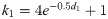
Shown is the dependence of mean expression (A, B) and expression noise (C, D) on the blue loop length (along the DNA line) for three fundamental patterns: alternating loops, nested loops and side-by-side loops. Here the side-by-side structure is taken as a control or reference since the blue loop length does not affect the expression level nor the noise intensity (see green lines). In all cases, parameter values are set as μ = 10, δ = 1, r = 0, d2 = 1500, λ21 = λ32 = λ34 = λ41 = 0.3, k2 = 0.5, and k1=4e−0.5d1+1 with d1 ∈ (0,1000).